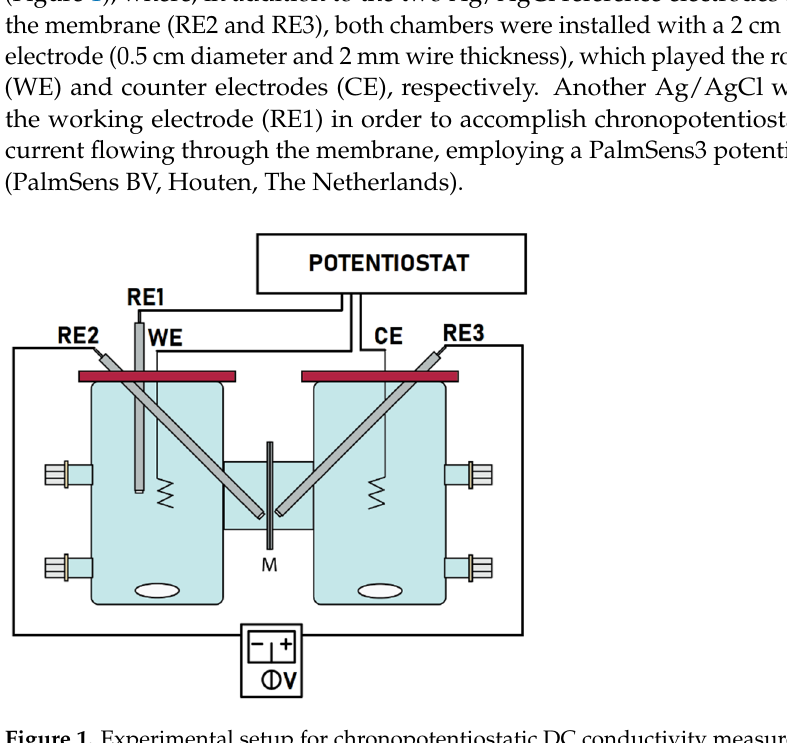
Figure 1. Experimental setup for chronopotentiostatic DC conductivity measurements. The covered range of current density (relative to the membrane surface area) was 10 − 3 –1 mA cm − 2 in accordance with practical MFC current densities [32]. The φ , similarly to the transport number measurements, was registered by a digital multimeter. The ex- periments were carried out at various electrolyte (KCl) concentrations from 0.05 M to 0.5 M. The electrolyte solutions were continuously stirred during the tests (100 rpm). To ob- of the membrane. The slope of the current- φ linear plot for the membrane-less condi-